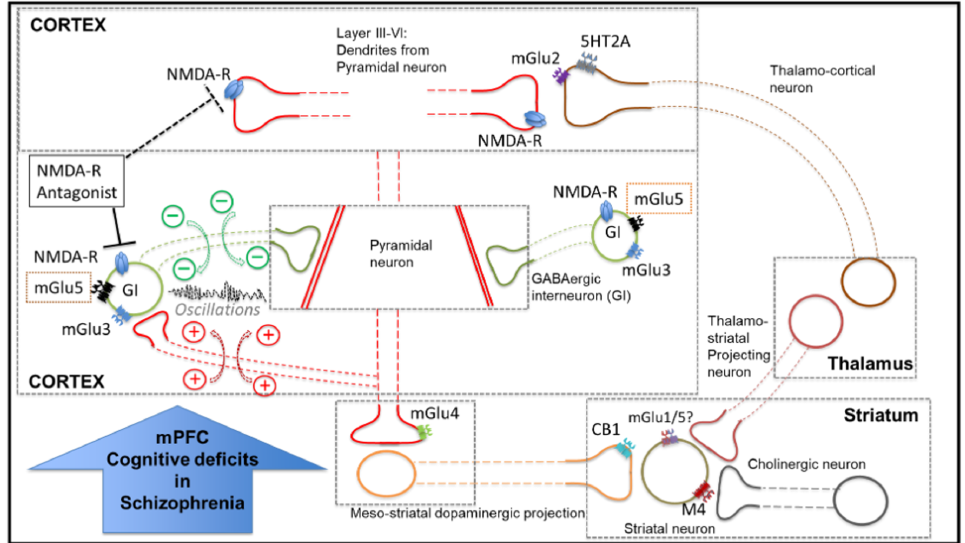
Figure 8. Diagram illustrating an overview of mGlu receptor subtypes and other relevant receptors involved in a mechanistic network in the pathophysiology of schizophrenia. A hypothetical role of the mGlu5 receptor (mGlu5) in this network involves connectivity between an excitatory pyramidal neuron (in red) and inhibitory interneurons expressing mGlu5 (in green). The inhibitory interneurons, including parvalbumin-expressing neurons, are dynamically positioned to produce synchronous oscillations, such as gamma-band oscillations, through recurrent feedback inhibition (GABAergic interneurons in green) and excitation by pyramidal neurons (collateral axon projection indicated in red). This connectivity is disturbed in schizophrenia, disrupting gamma oscillations, and producing cognitive deficits. mGlu5 receptor subtypes are expressed in interneurons (in green) and in pyramidal neurons (not shown here). In addition, functional interaction between mGlu3 and mGlu5 has been demonstrated in the CNS, with mGlu3 receptor activation enhancing mGlu5 signalling [80]. Speculatively, group I mGluR (mGlu1/5) activation also induces the release of endocannabinoids, which in turn activate presynaptic CB1 receptors on mesostriatal dopaminergic neurons, thereby reducing dopamine release. Finally, mGlu5 receptor subtypes are functionally coupled with N- methyl-D-aspartate (NMDA) receptors. Biased pure mGlu5 receptor PAMs that do not induce NMDA receptor activation are devoid of toxic effects related to NMDA coupling. Derivatives of these PAMs such as VU0409551 and VU0360172 that do not induce coupling of mGlu5 receptors to NMDA receptors are under development for the unmet therapeutic need of